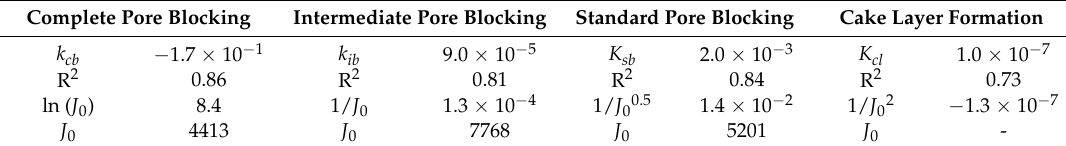
Table 4. Hermia’s model parameters obtained from the linear regression analysis for the ceramic filter.